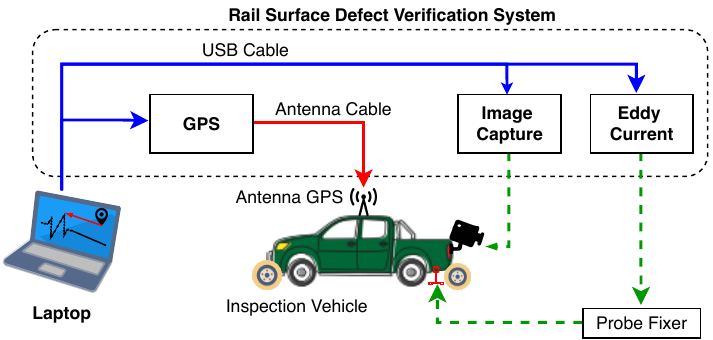
Figure 2. Rail surface defect verification system diagram.